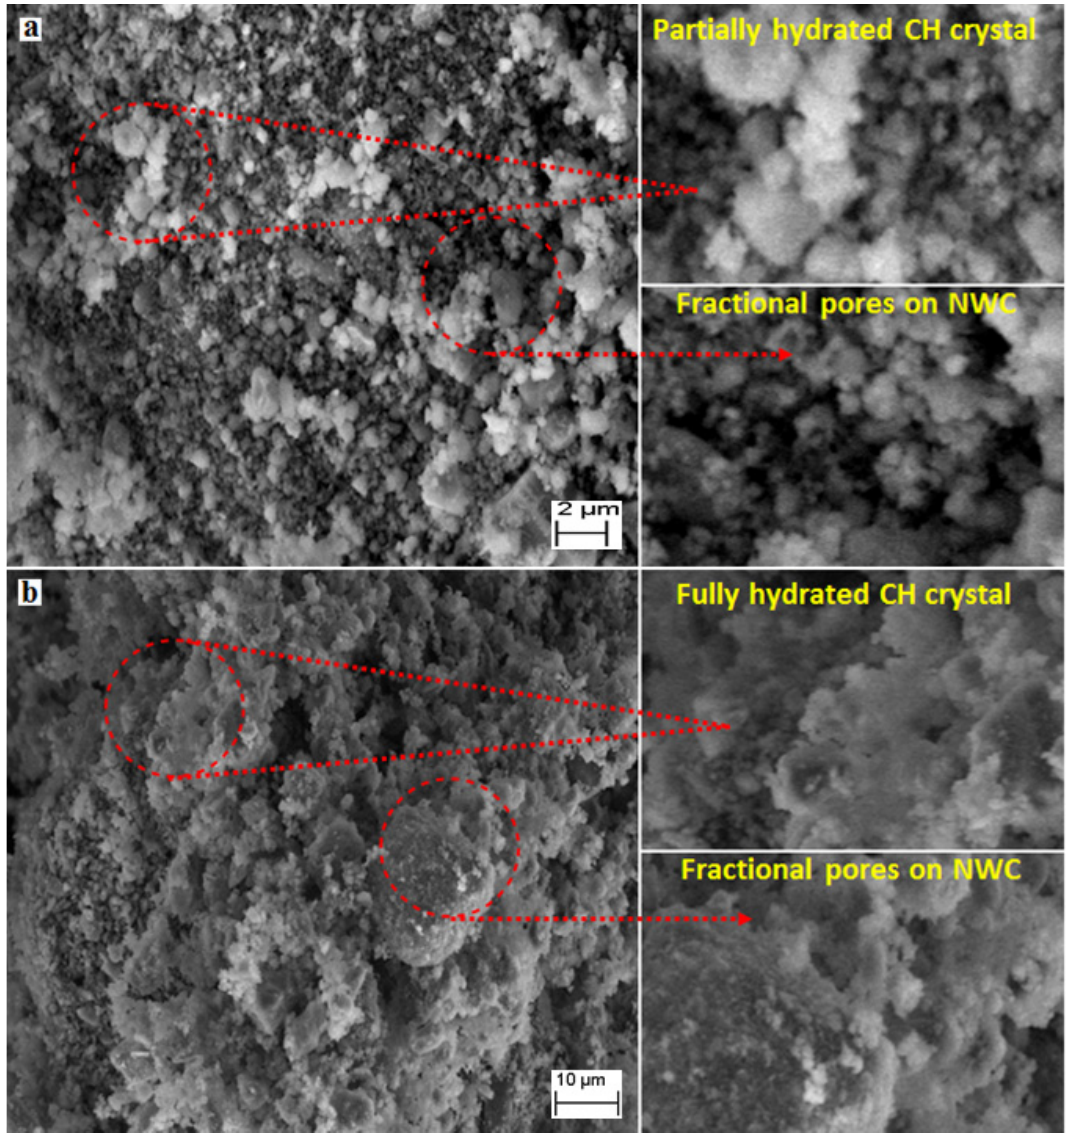
Materials 2022 , 15 , x FOR PEER REVIEW Figure 13. SEM micrograph of fractional voids in cement paste prepared with ( a ) NWC and ( b ) MWC.